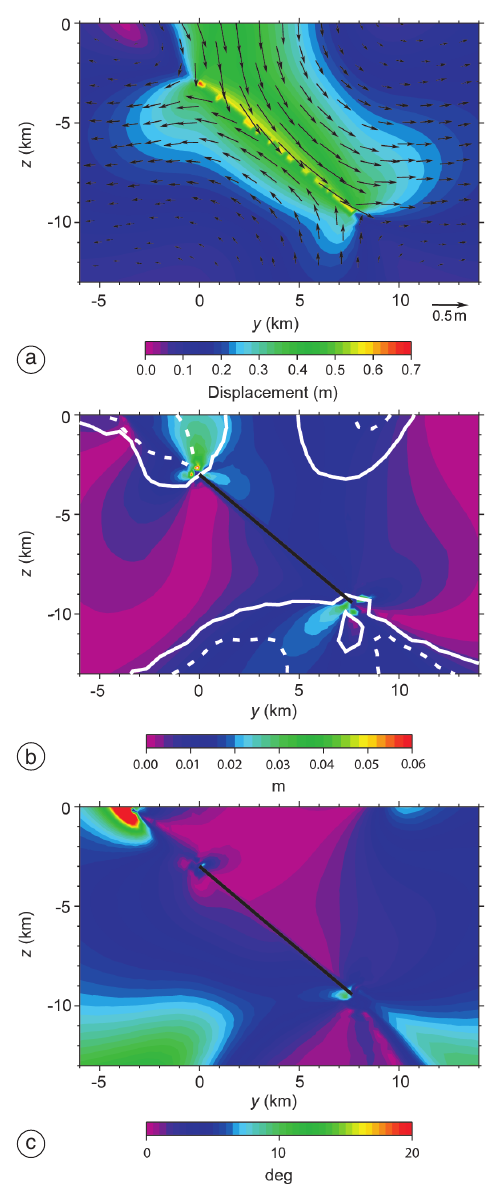
Fig. 4a-c. a) Displacement field computed through finite element model of fig. 1a,b. b) Difference (misfit) between the numerical (FEM) and the analytical dis- placement fields: contours of absolute (color bands) and relative (white dashed line: 10%, white solid line: 5%) differences in value. c) Orientation misfit (inner angle). The black solid line represents the